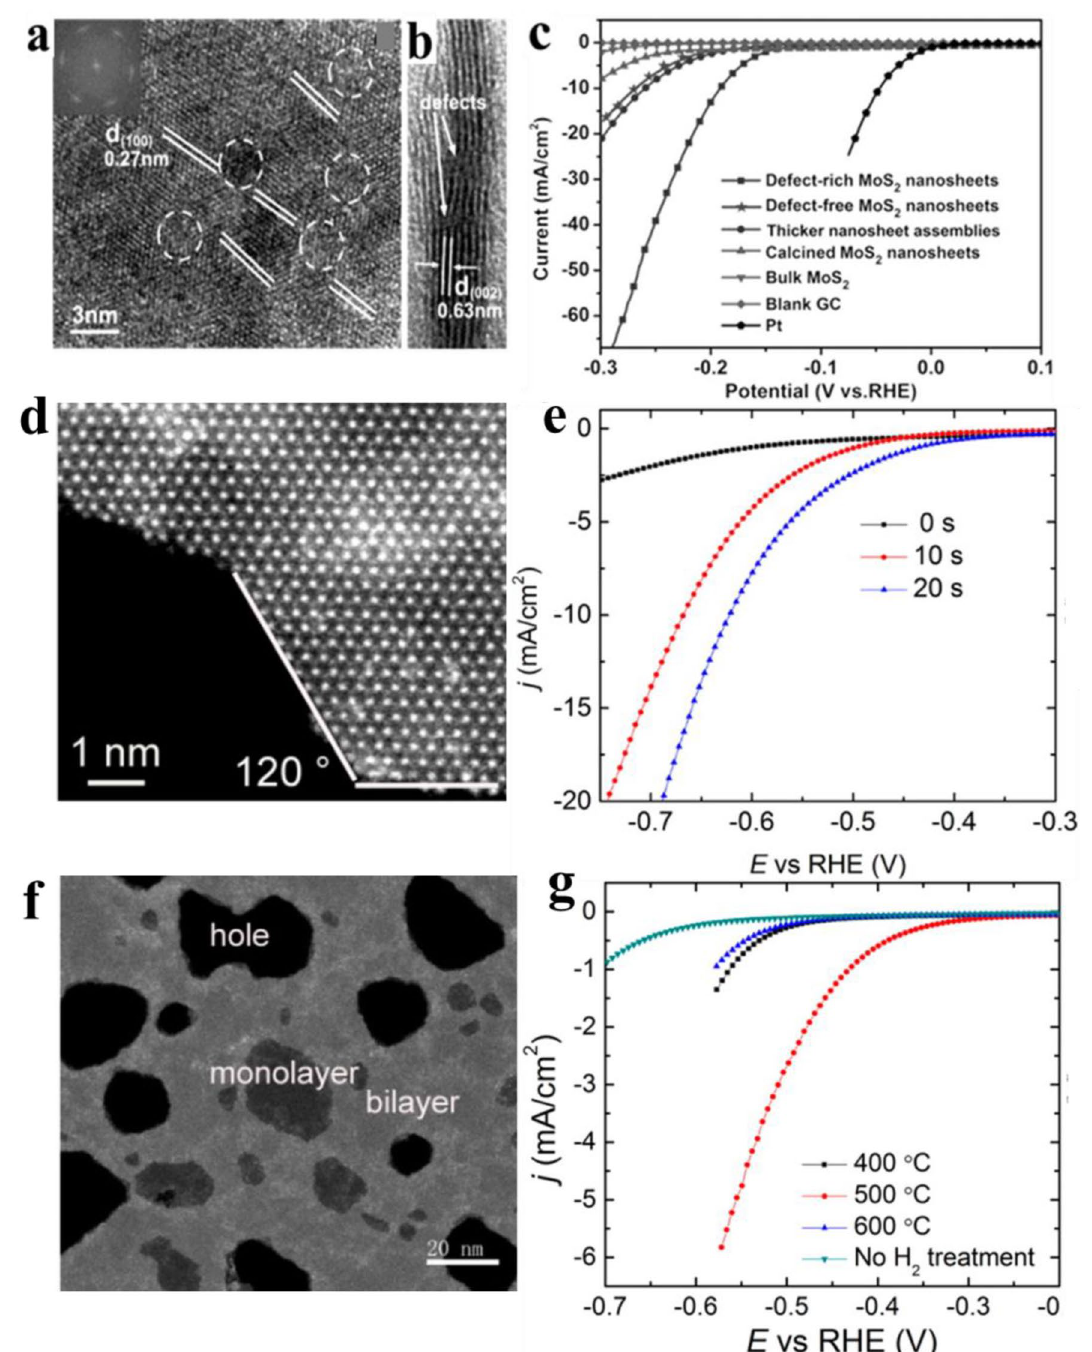
Fig. 2 a HRTEM image and the corresponding FFT patterns of the defect-rich MoS 2 ultrathin nanosheets. b Cross-sectional HRTEM image of the defect-rich MoS 2 ultrathin nanosheets. c Polariza- tion curves of the defect-free MoS 2 nanosheets, defect-rich MoS 2 nanosheets, thicker MoS 2 nanosheet assemblies, calcined MoS 2 nanosheets, bulk MoS 2 , blank glassy carbon, and Pt [44], d STEM